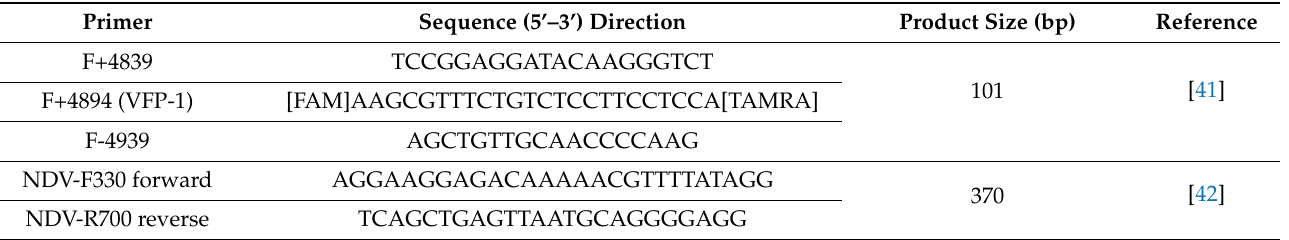
Table 2. Details of the two sets of primers and probes used for amplification of the NDV gene fragment in real-time reverse transcriptase polymerase chain reaction (RRT-PCR) and RT-PCR.